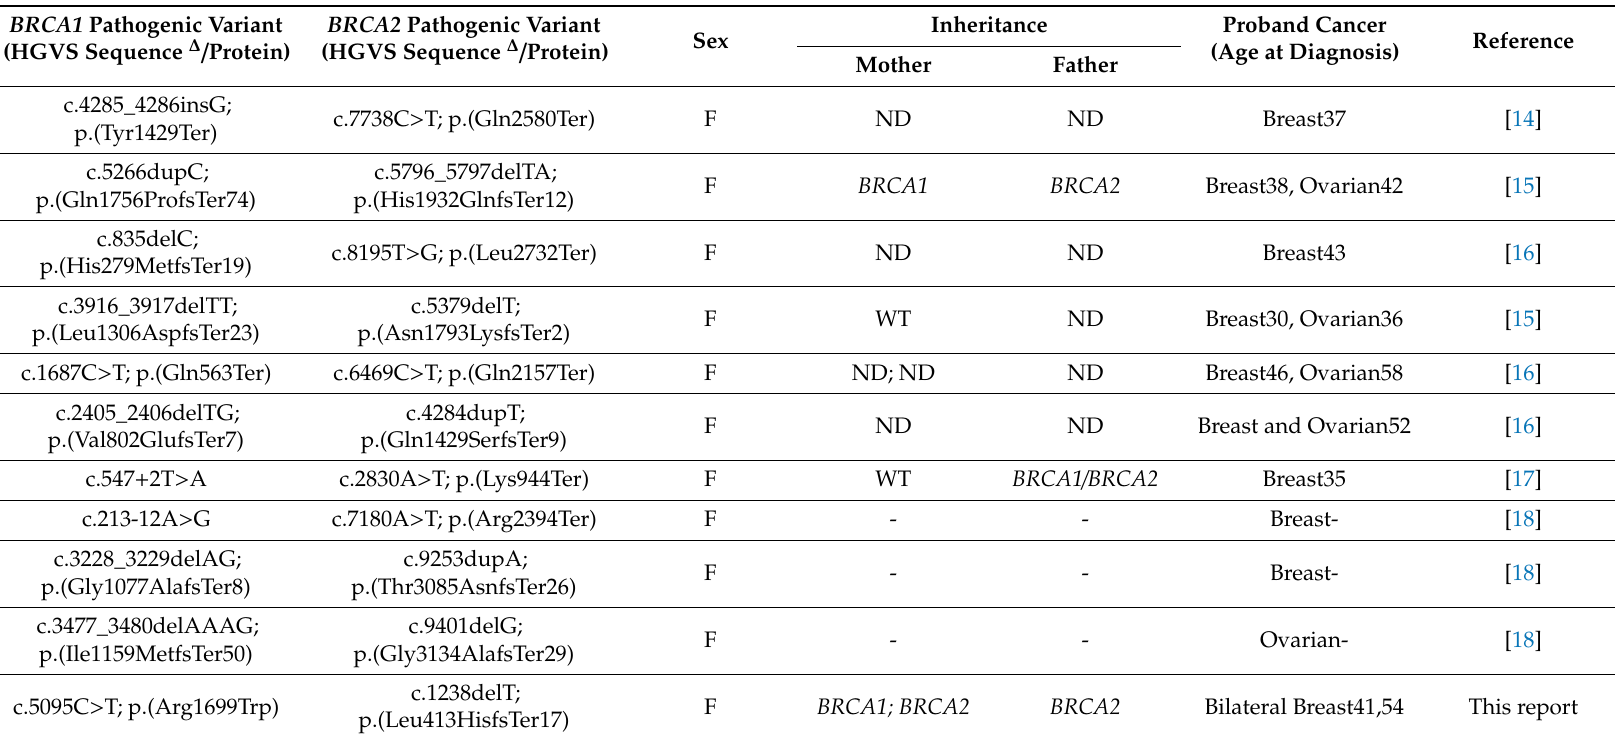
Table 2. Italian patients carrying pathogenic variants at both BRCA1 and BRCA2 . Data from literature review. BRCA1 Pathogenic